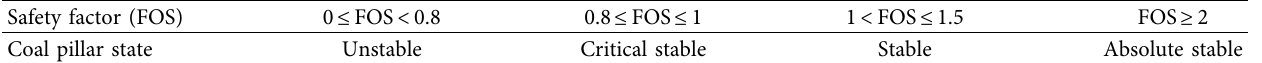
Table 3: Coal pillar safety factor.